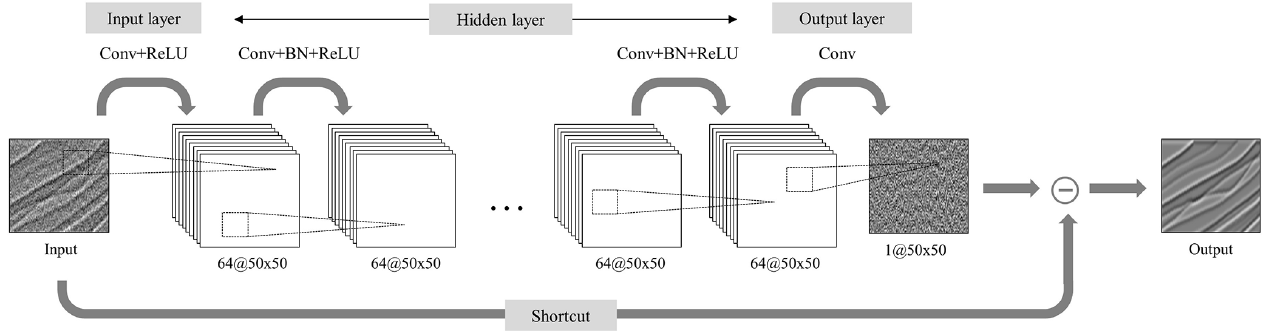
Figure 1. DnCNN architecture. 64@50 × 50 indicates 64 feature maps with 50 × 50 size, Conv is the two-dimensional 3 × 3 convolution kernel, BN is batch normalization, and ReLU is the rectified linear unit activation function.